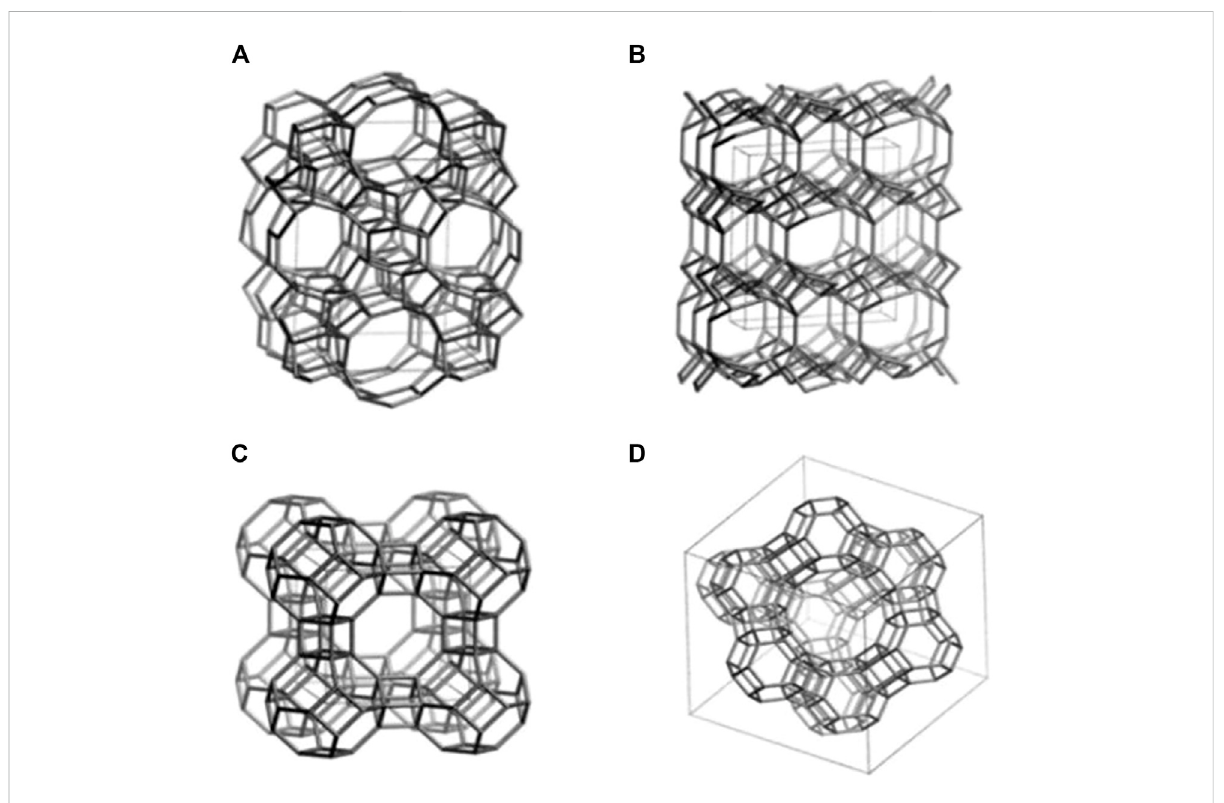
FIGURE 1 Structural models of several types of zeolites including (A) ZSM-5, (B) Clinoptilolite, (C) Zeolite A, and (D) Zeolite Y (Servatan et al.,